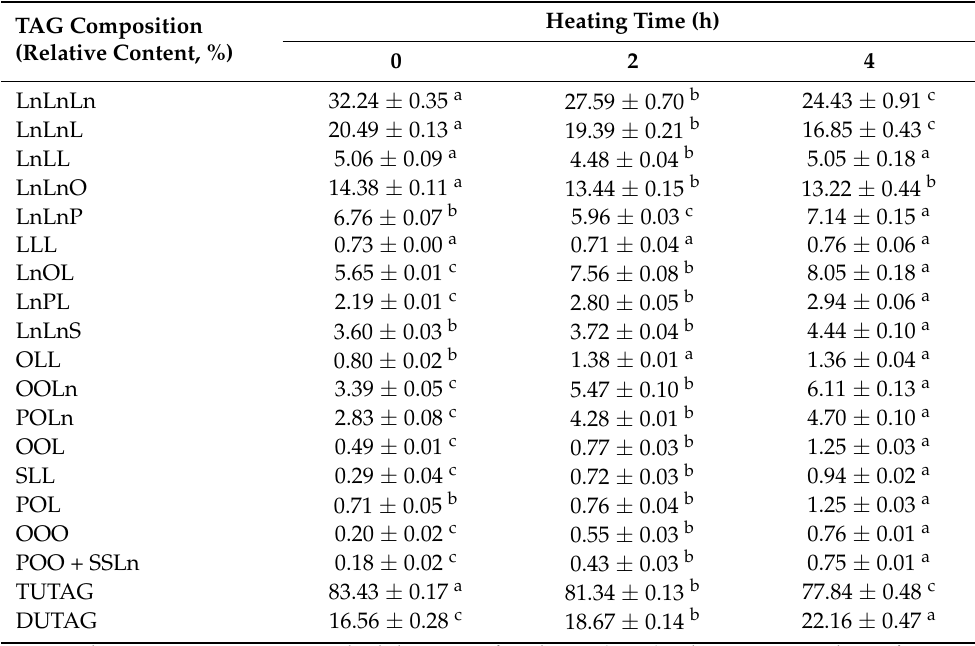
Table 2. Changes in TAG profile of flaxseed oil during heating at 180 ◦